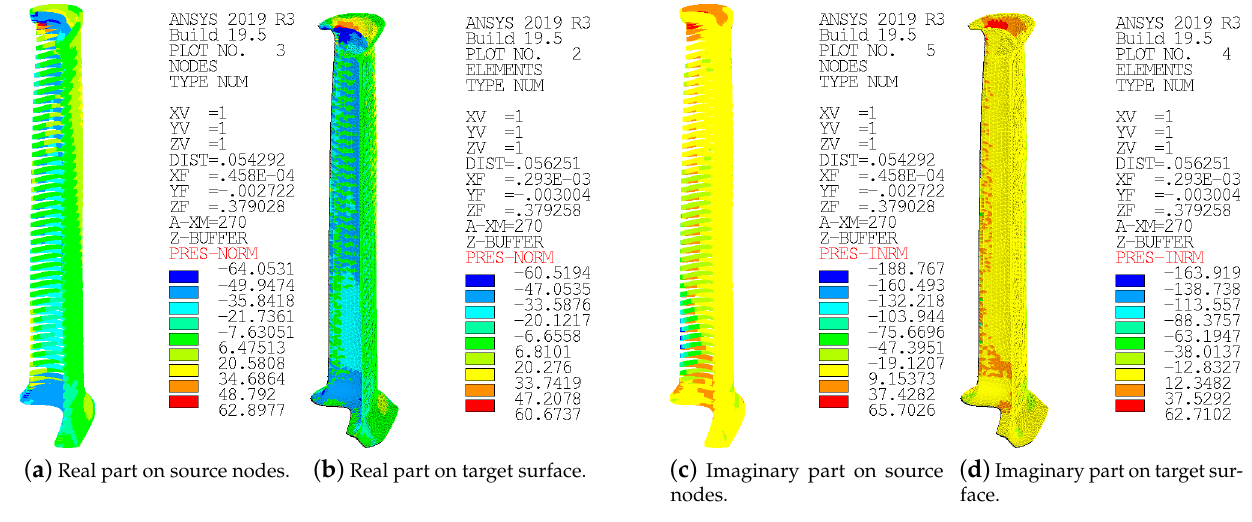
Figure 14. Check on forcing distribution mapping (EO = 7).